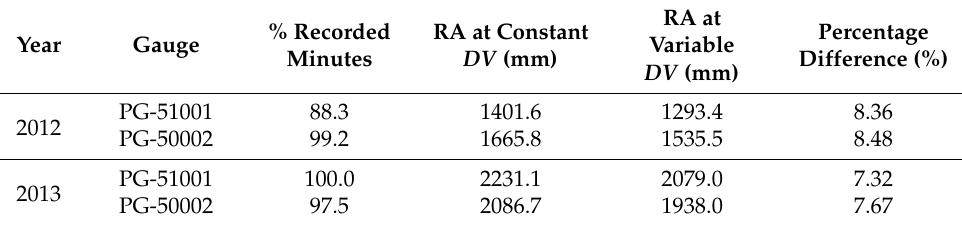
Table 4. Rainfall amount for the selected events recorded by the two OSC gauges at the HKIA field test site using a constant and a variable drop volume ( DV ). % Recorded RA at Constant Year Gauge Minutes